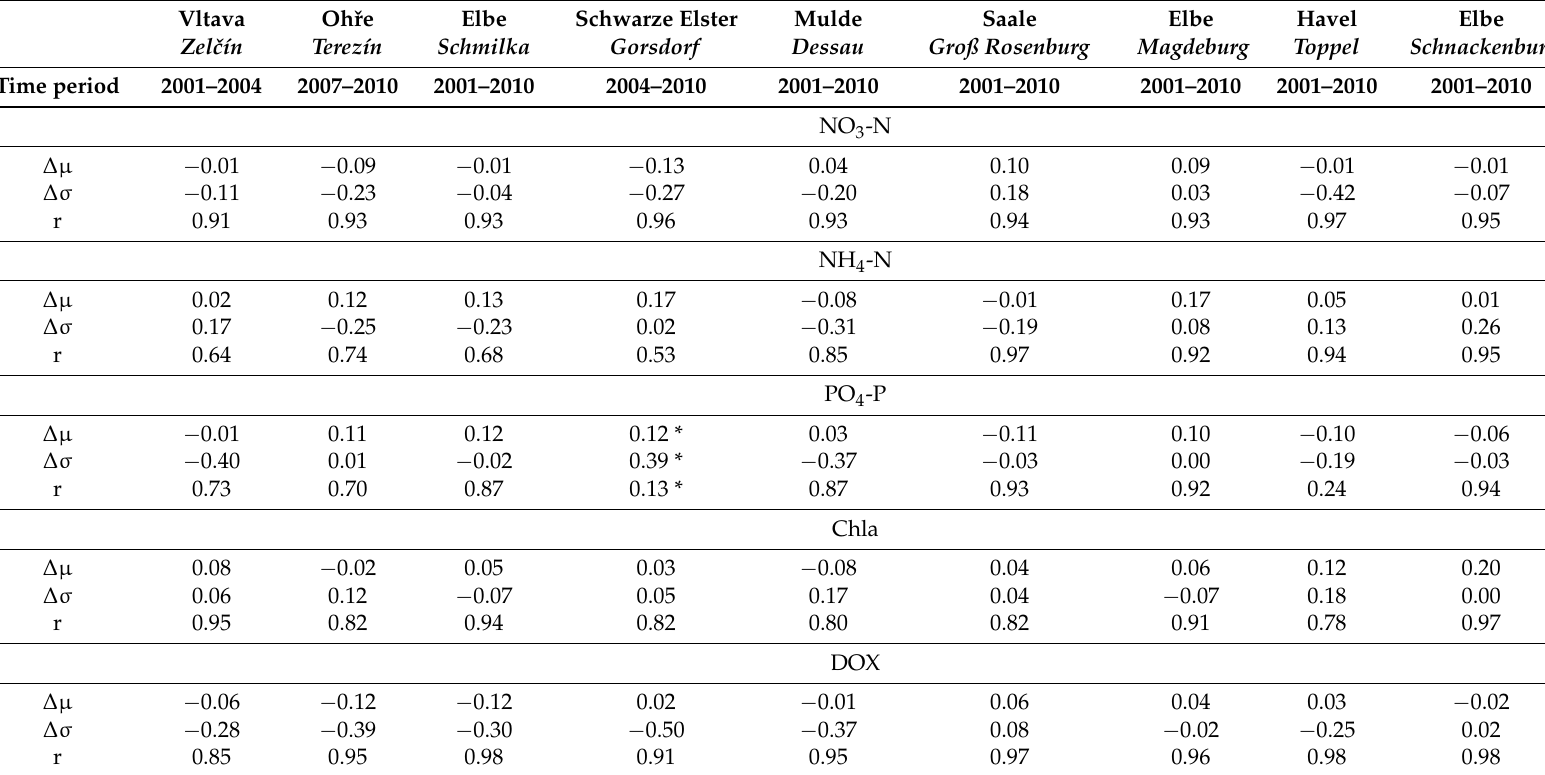
Table 7. Model ability to simulate the long-term monthly average loads of water quality variables for six main tributaries as well as three selected Elbe water quality observation gauges in the time period 2001–2010 after spatially distributed model calibration. The model performance variables were calculated according to [75] and are described in Section